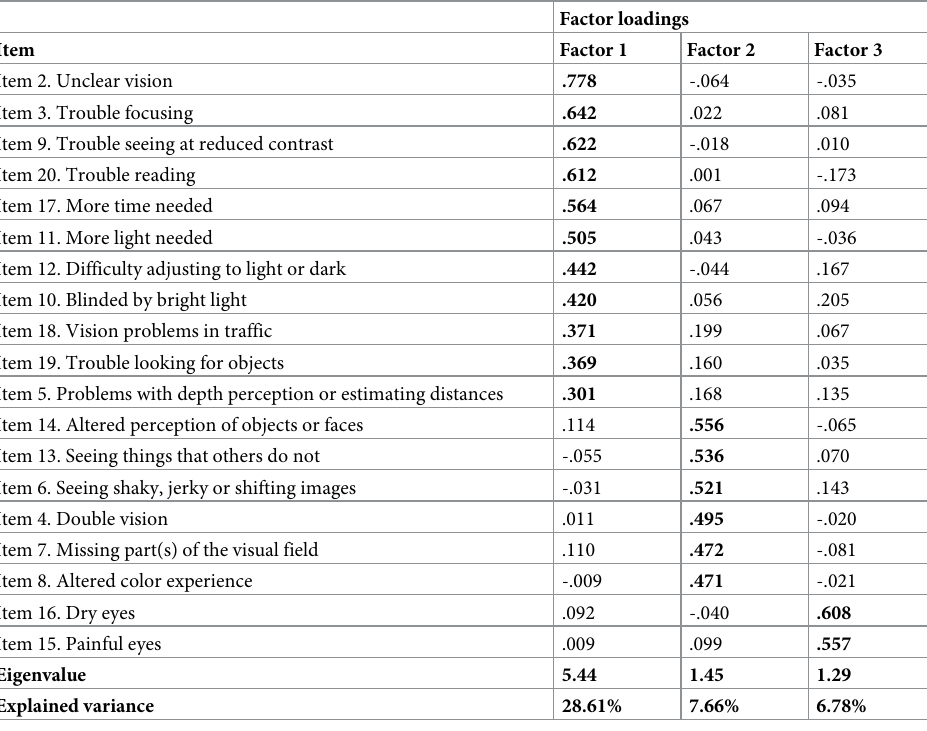
Table 3. Results of the principal axis